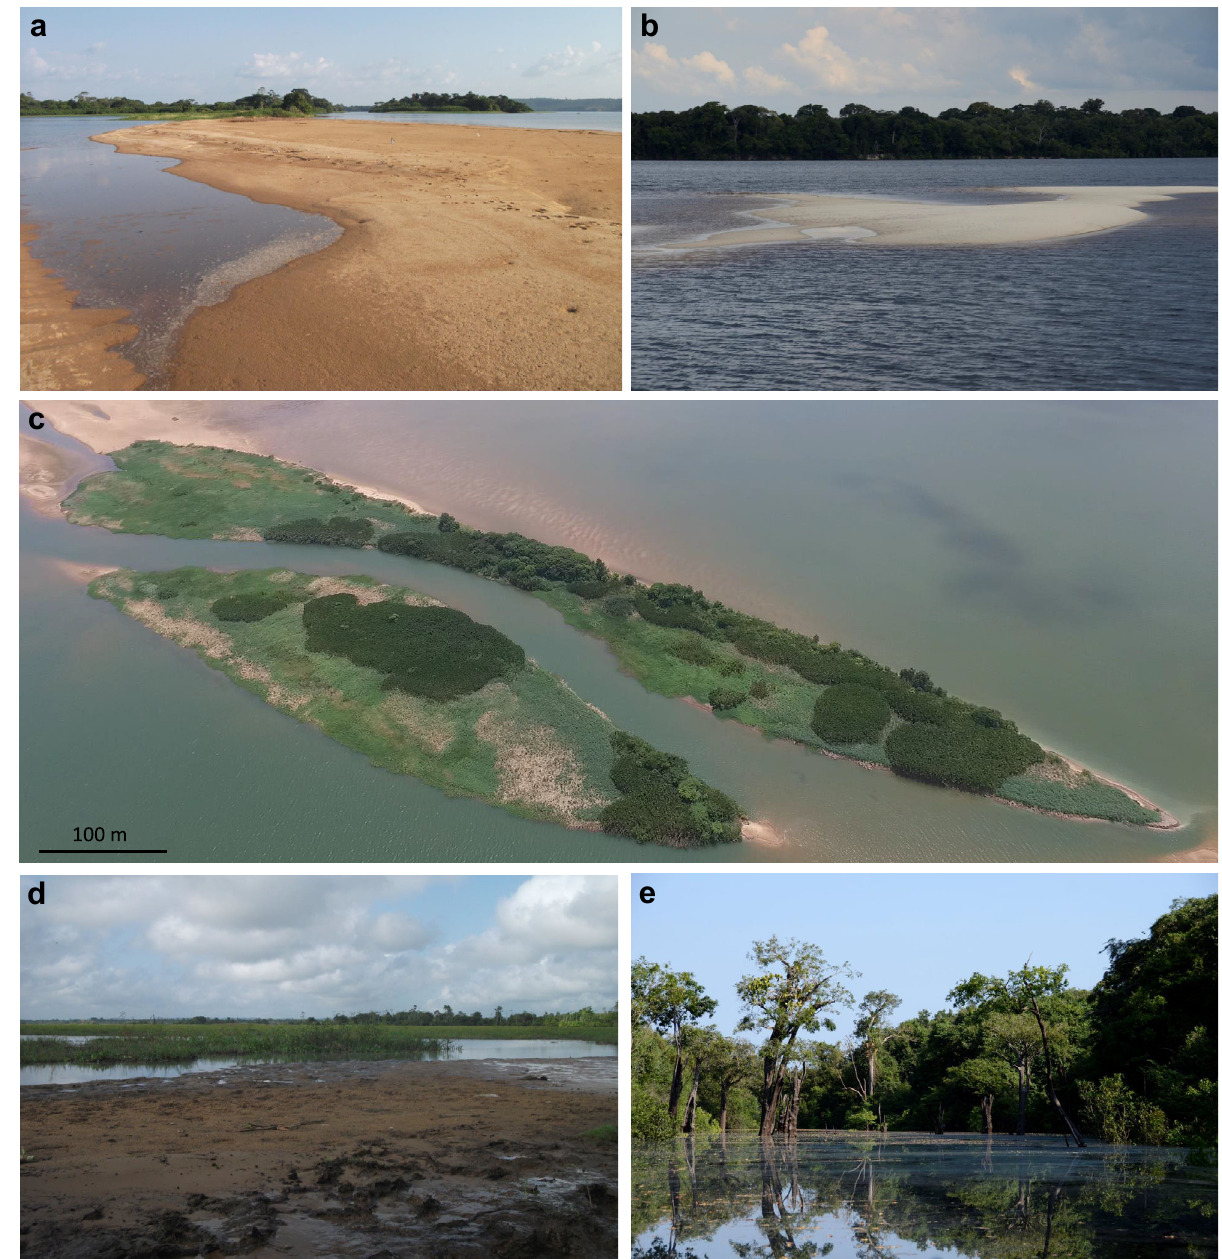
Fig.3|Developmentofseasonally fl oodedvegetationoversandybar.a , b Sand bartop exposed during the low-stage water level. c Sand barpartiallycolonized by grass and bush vegetation. d Sand bar top with deposition of silt and clay on slack water zone formed by vegetation growth. e Mature fl ooded forest ( igapó )